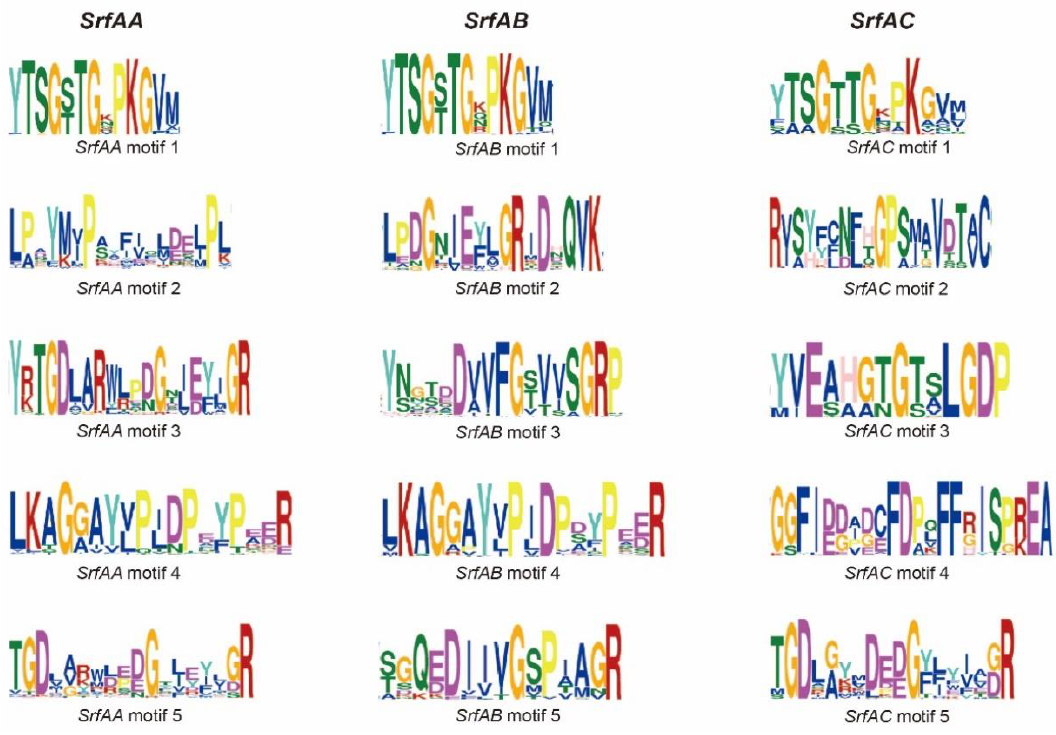
Figure 3. Conserved motifs of SrfAA , SrfAB and SrfAC proteins.